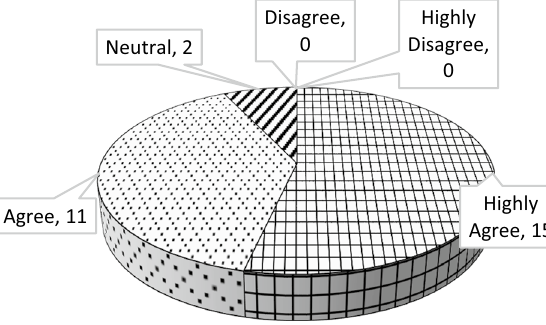
Fig. 5 Survey response of organizational factors by Pakistani ICT